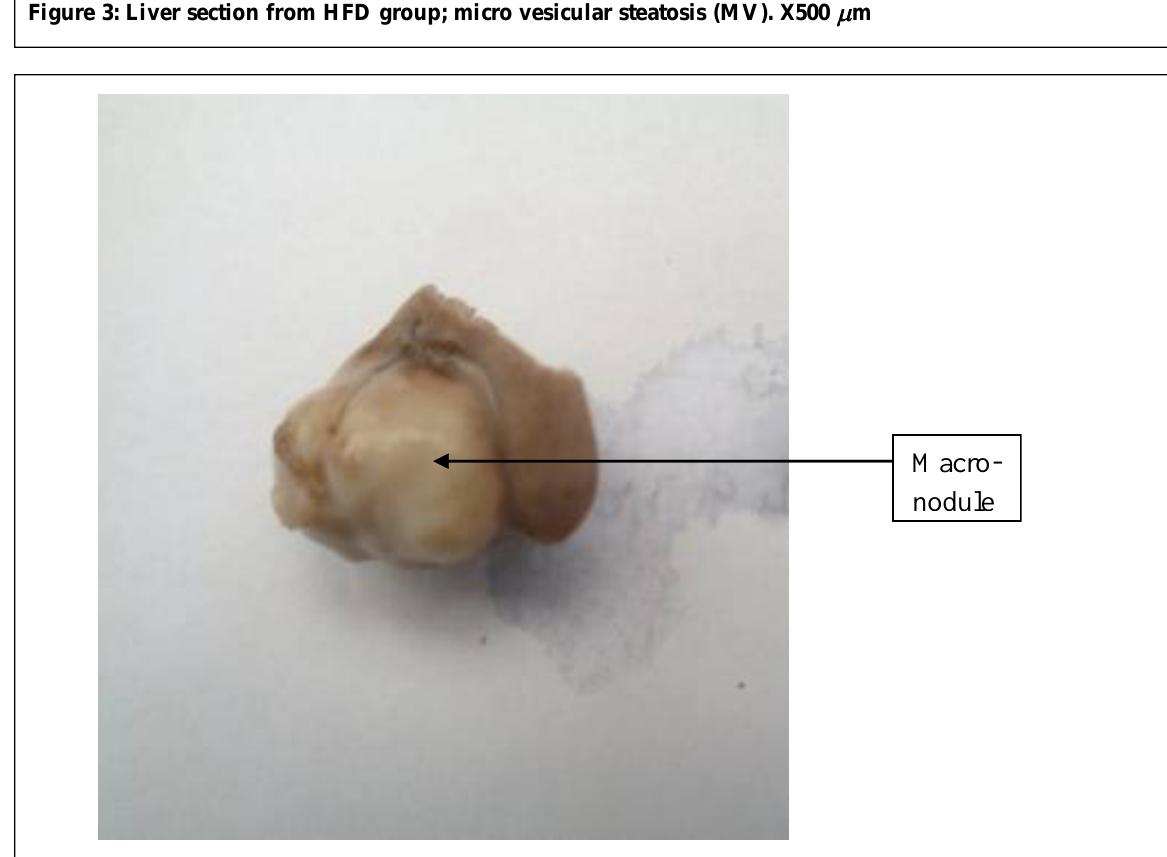
Figure 4: A fixed liver from RHFD group, macro-nodular